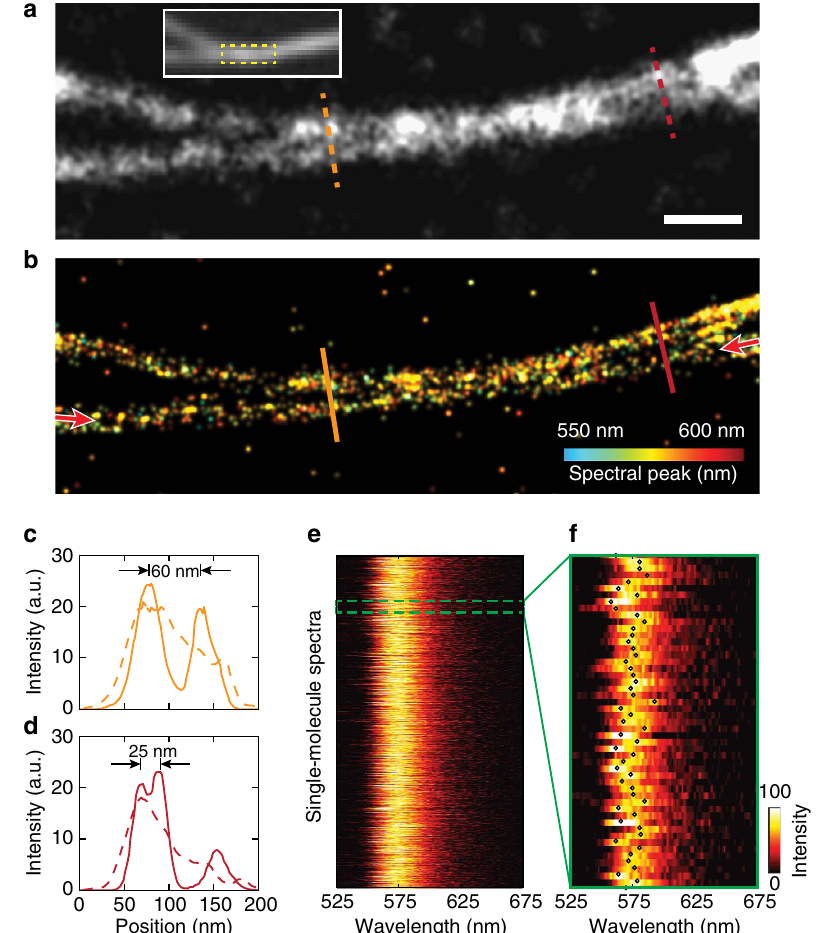
Figure 3 | Imaging ex vivo microtubules using SPLM. ( a ) Conventional PLM image of two closely spaced microtubules of the square region in the wide-field fluorescence image, as shown in the inset. Scale bar, 200nm. ( b ) SPLM image with spectral regression. ( c , d ) are the line profiles from positions highlighted by the dashed and solid lines in a , b , respectively. ( e ) Emission spectra along a single microtubule, highlighted by the arrows in b . ( f ) Magnified view of the spectral variation. The circles indicate the peak positions of each PLM image of two closely spaced microtubules. After applying spectral regression, we rendered a SPLM image, as shown in Fig. 3b, with the colour representing the peak wavelength of each molecule. As shown by the line profiles in Fig. 3c, the two microtubules, which were difficult to distinguish from each other in the PLM image (dashed line), can be clearly resolved in the SPLM image (solid line). Features as small as 25 nm can be resolved from single microtubules (Fig. 3d). Figure 3e shows the spectra of all localization events in one of the microtubules, indicated by arrows in Fig. 3b. As illustrated in the magnified view (Fig. 3f), dye molecules of the same type have variations in spectral emissions due to the underlying fluorescent